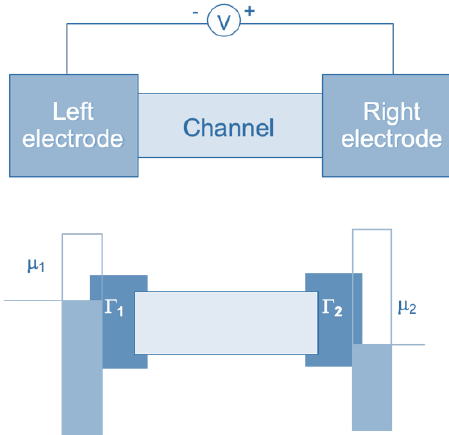
Figure 1. Schematic two terminal device used for the non-equilibrium Green’s function (NEGF) transport simulation. The electrochemical potentials of the left (μ 1 ) and right (μ 2 ) electrodes are shifted by qV when a bias V is applied to the structure. The self-energies Γ 1 and Γ 2 at the contacts are indicated.